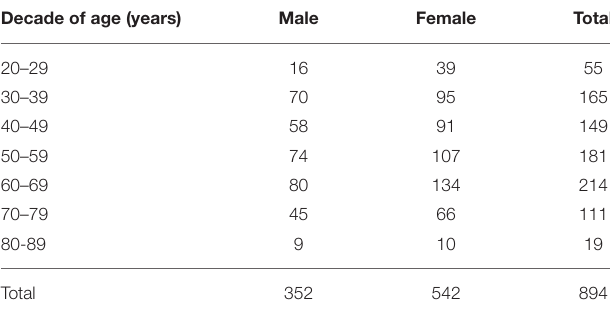
TABLE 2 | The examined number of cases in each decade of